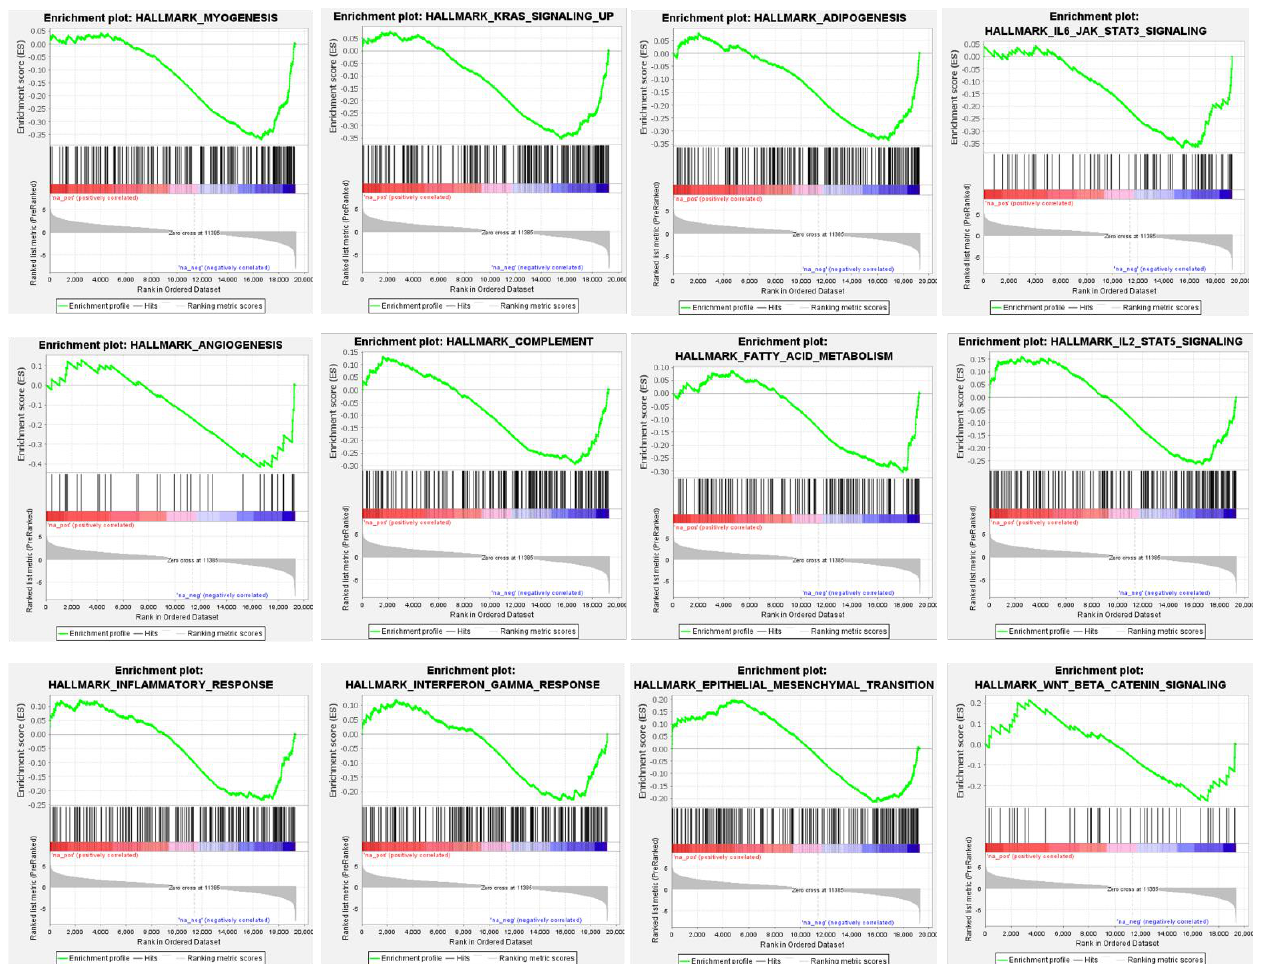
Figure 4. Gene Set Enrichment Analysis (GSEA) of RNAseq profiles between paired CNBs and surgical specimens. Examples of histograms showing the distribution of the Hallmark of cancer pathways enriched among genes showing significantly lower expression in CNBs compared with the paired surgical specimens. Refer to Supplementary Table S3 for the full list of the enriched Hallmark of cancer pathways among the genes with lower expression in CNBs compared with surgical specimens.